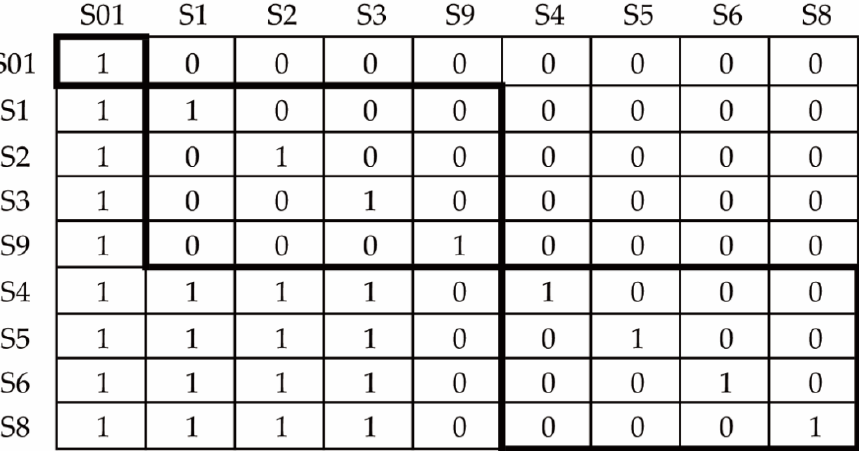
Figure 6. Reachability matrixes after ranking of quantitative decision making.